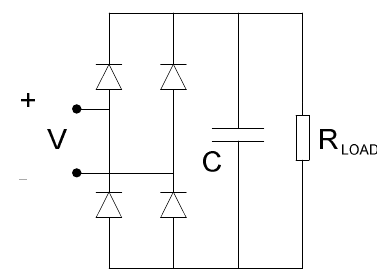
Figure 12. Full bridge rectifying circuit. During its operation, two voltage drops on the diode have to be compensated.